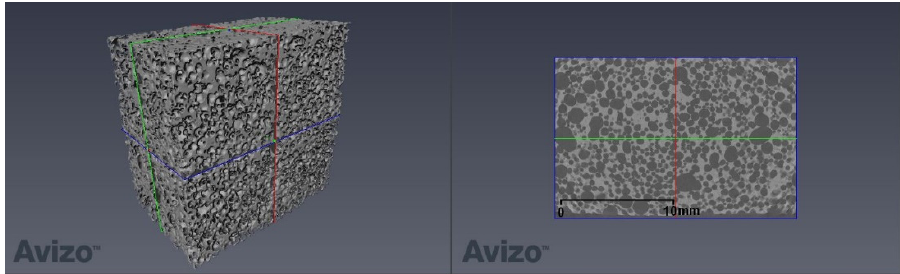
Figure 4. Measurement data for one of the samples—a 3D view and selected layer in the xy plane.